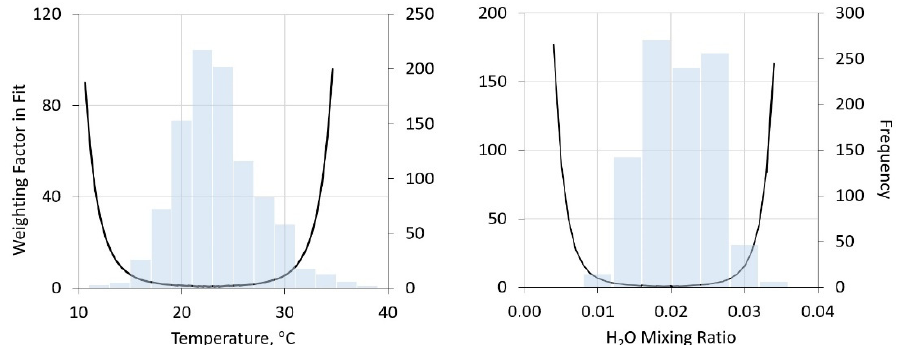
Figure 2. Frequency distribution of lowest altitude (surface to 1 km) temperatures ( left ) and water mixing ratio ( right ) in Dulles airport radiosonde launches (grey bars) and the derived “weighting factor” for fitting, as defined in Section 3.1.3 below.